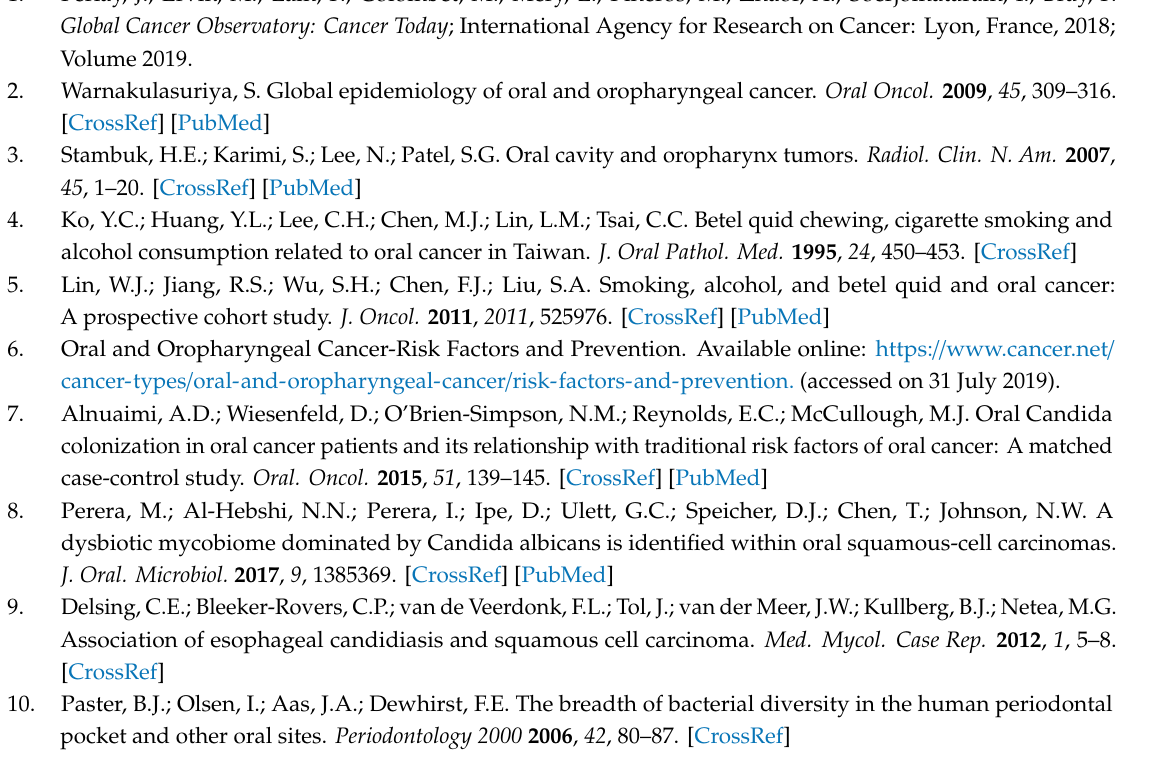
Supplementary Materials: The following are available online at http: // www.mdpi.com / 2072-6694 / 12 / 11 / 3148 / s1, Figure S1: Western blotting analysis of protein expression of LDOC1 in immortalized human normal oral keratinocyte cell line CGHNK2, human dysplasia oral keratinocyte cell line (DOK), and OSCC cell lines (TW2.6, OC3, SCC15), Figure S2: LDOC1 may function as an immune modulator upon pathogen